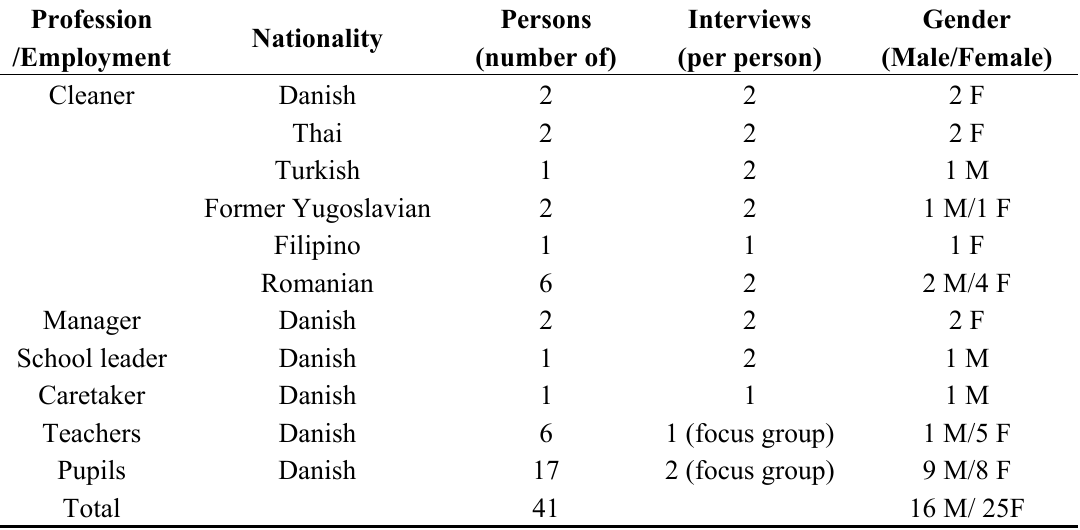
Table 2. Study population divided into profession, nationality and gender.